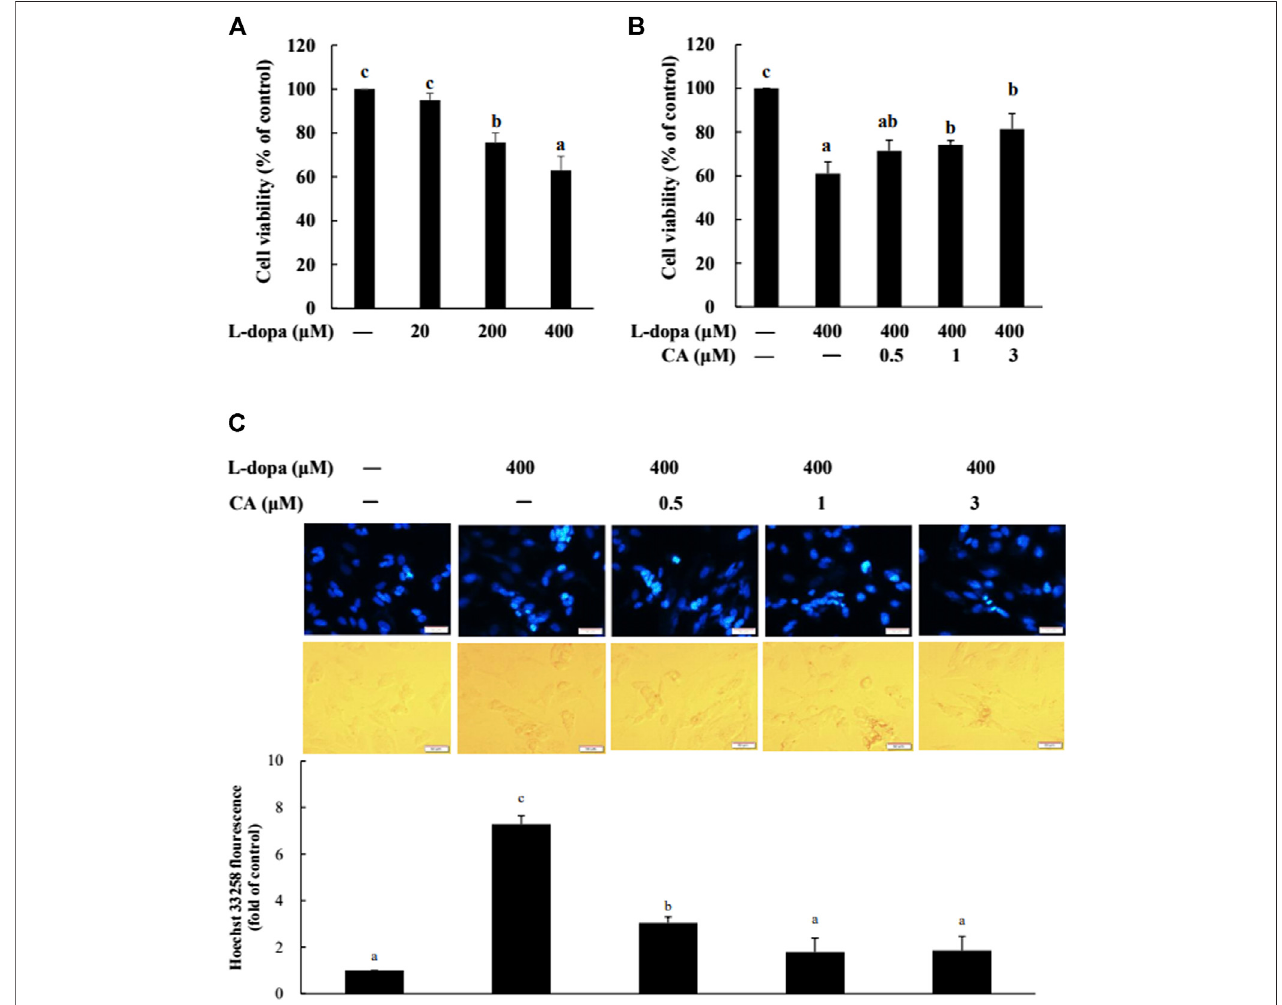
FIGURE 5 | Effect of CA on L -dopa-induced toxicity in SH-SY5Y cells. Cell viability was measured by MTT assay. (A) Cells were pretreated with 20, 200, and 400 μ M L -dopa for 72 h. Control ( − ) was treated with PBS. (B) Cells were pretreated with 0.1% DMSO alone ( − ) or 0.5, 1, and 3 μ M CA for 18 h and were then treated with 400 μ M L -dopa for an additional 72 h. (C) Nuclei were visualized with Hoechst 33258 staining. Cells were pretreated with DMSO alone ( − ) or 0.5, 1, or 3 μ M CA for 18 h and were then treated with 400 μ M L -dopa for an additional 24 h. One representative image out of three independent experiments is shown. Values are mean ± SD ( n (cid:1) 3). Means not sharing a common letter are signi fi cantly different, p < 0.05.